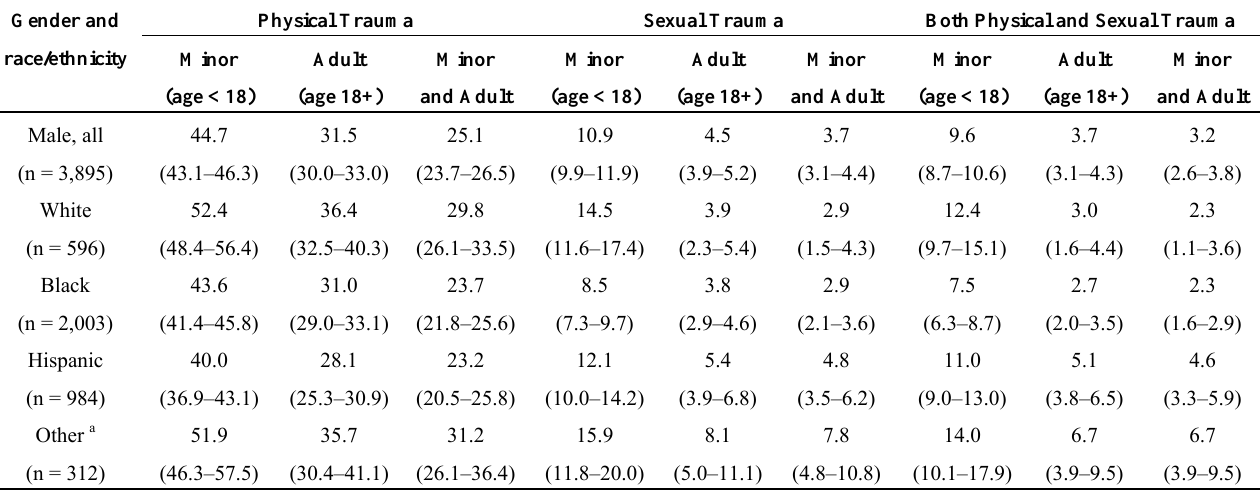
Table 1. Prevalence estimates of trauma experienced by incarcerated men by race, type of trauma and age at time of